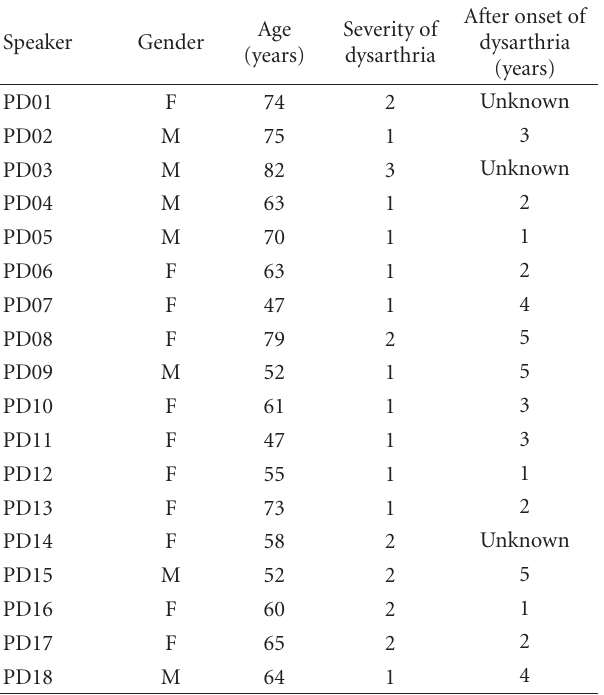
Table 3: PD speaker